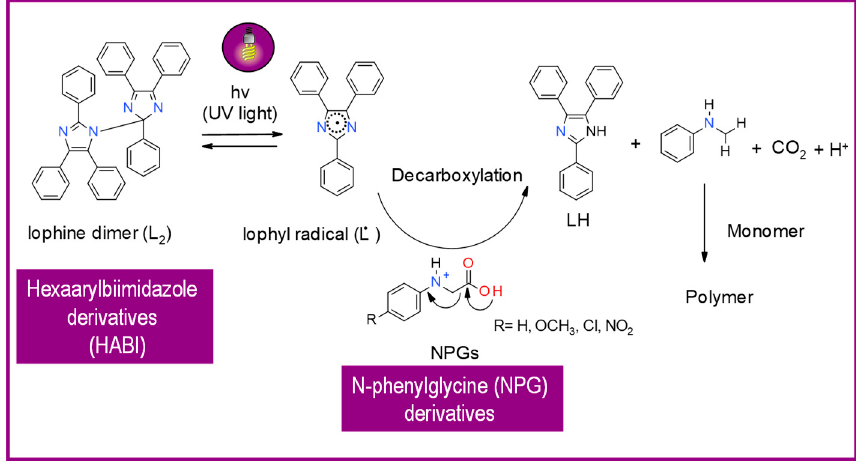
Figure 17. Photoinitiation process of type-II photoinitiator systems based on 2-chlorohexaarylbiimidazole (o-Cl-HABI) and various N-phenylglycine (NPG) derivatives.